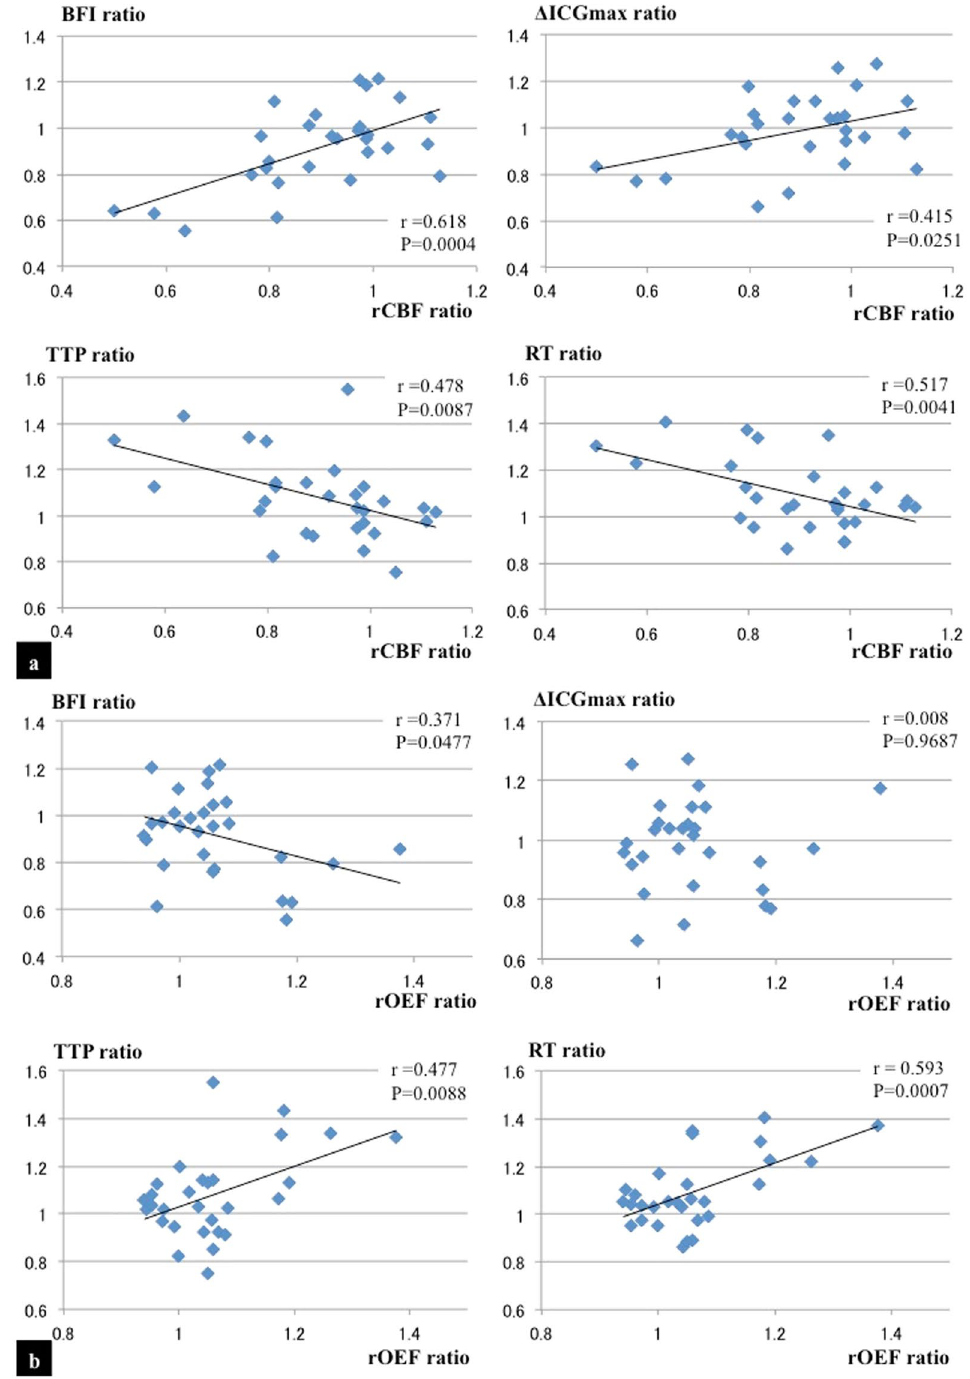
Figure 1. Correlations between the rCBF ratio and several NIRS/ICG parameters (BFI ratio, Δ ICGmax ratio, TTP ratio, and RT ratio) are shown ( a ). Correlations between the rOEF ratio and NIRS/ICG parameters are also demonstrated ( b ). Among the parameters of the NIRS/ICG, the BFI ratio shows the best correlation with the rCBF ratio (|r| = 0.618, P = 0.0004), and the RT ratio shows the best correlation with the rOEF ratio (|r| = 0.593, P =